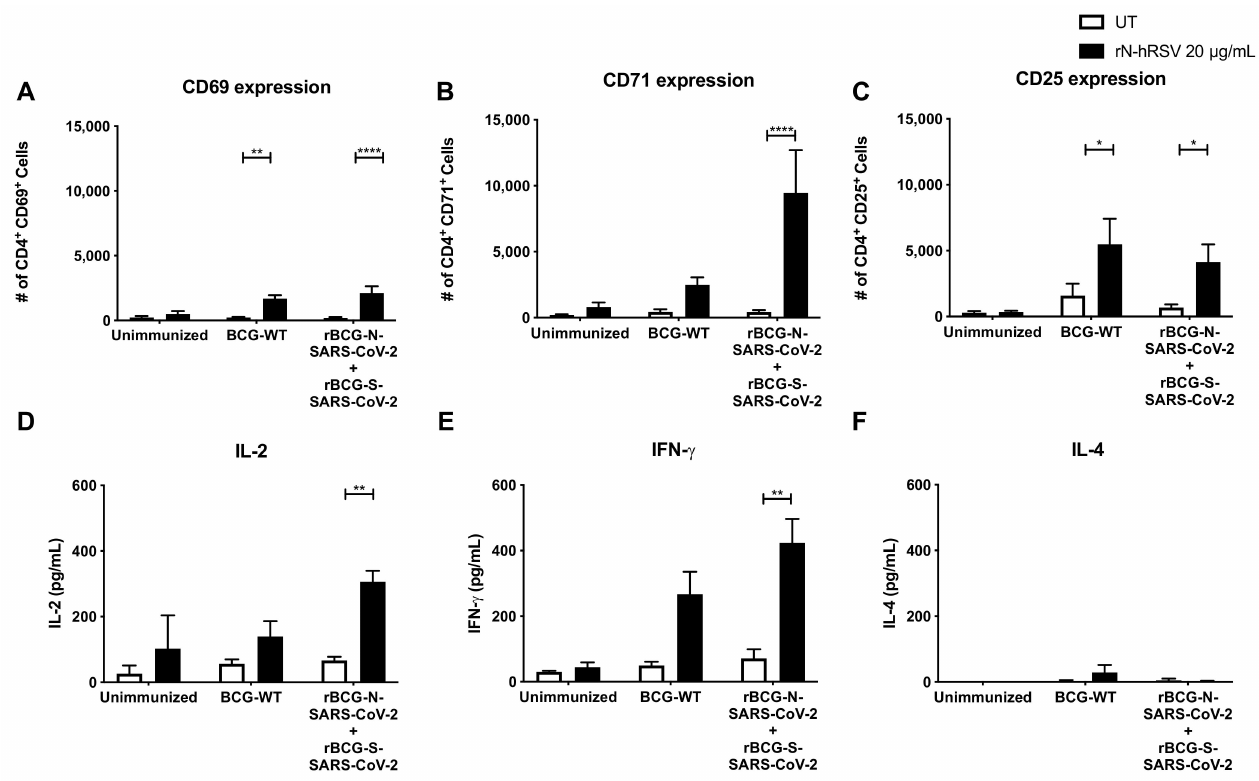
Figure 5. Evaluation of CD4 + T cell activation and cytokines concentration secreted ex vivo upon stimulation of purified T cells with a non-related antigen. The expression of the activation markers CD69 ( A ), CD71 ( B ), and CD25 ( C ) was evaluated by flow cytometry in purified T cells upon stimulation with the N-hRSV protein, an unrelated antigen. These purified T cells were obtained from mice unimmunized, immunized with BCG-WT, or immunized with a mix of rBCGs expressing either the N- or the S-SARS-CoV-2 protein. Accordingly, the secretion of IL-2 ( D ), IL-4 ( E ), and IFN- γ ( F ) were evaluated in the supernatants obtained from the stimulation of these T cells. Data are representative of 2 independent experiments. Each experiment considered a total of three mice per group. Statistical differences were assessed by two-way ANOVA with a post hoc Bonferroni test. *: p < 0.05; **: p < 0.01; ****: p <